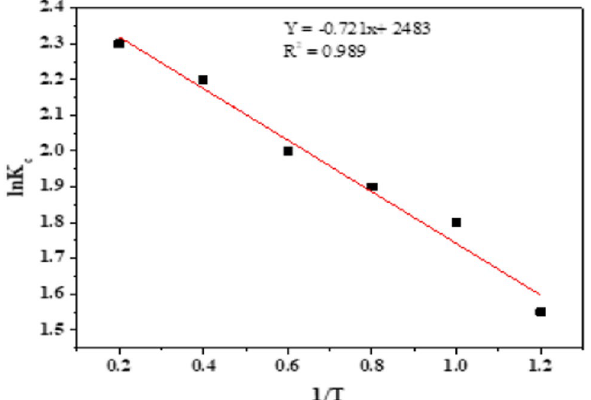
T for the adsorption c versus 1/